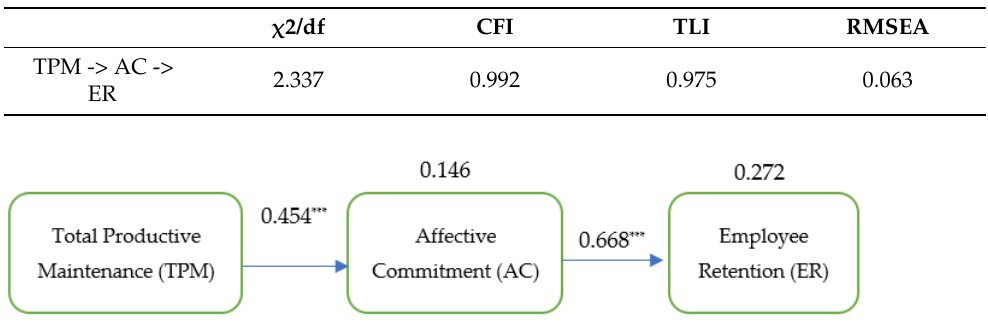
Figure 2. Proposed model with path coefficients. Note: Unstandardized coefficients are reported. *** p < 0.001 (two-tailed).